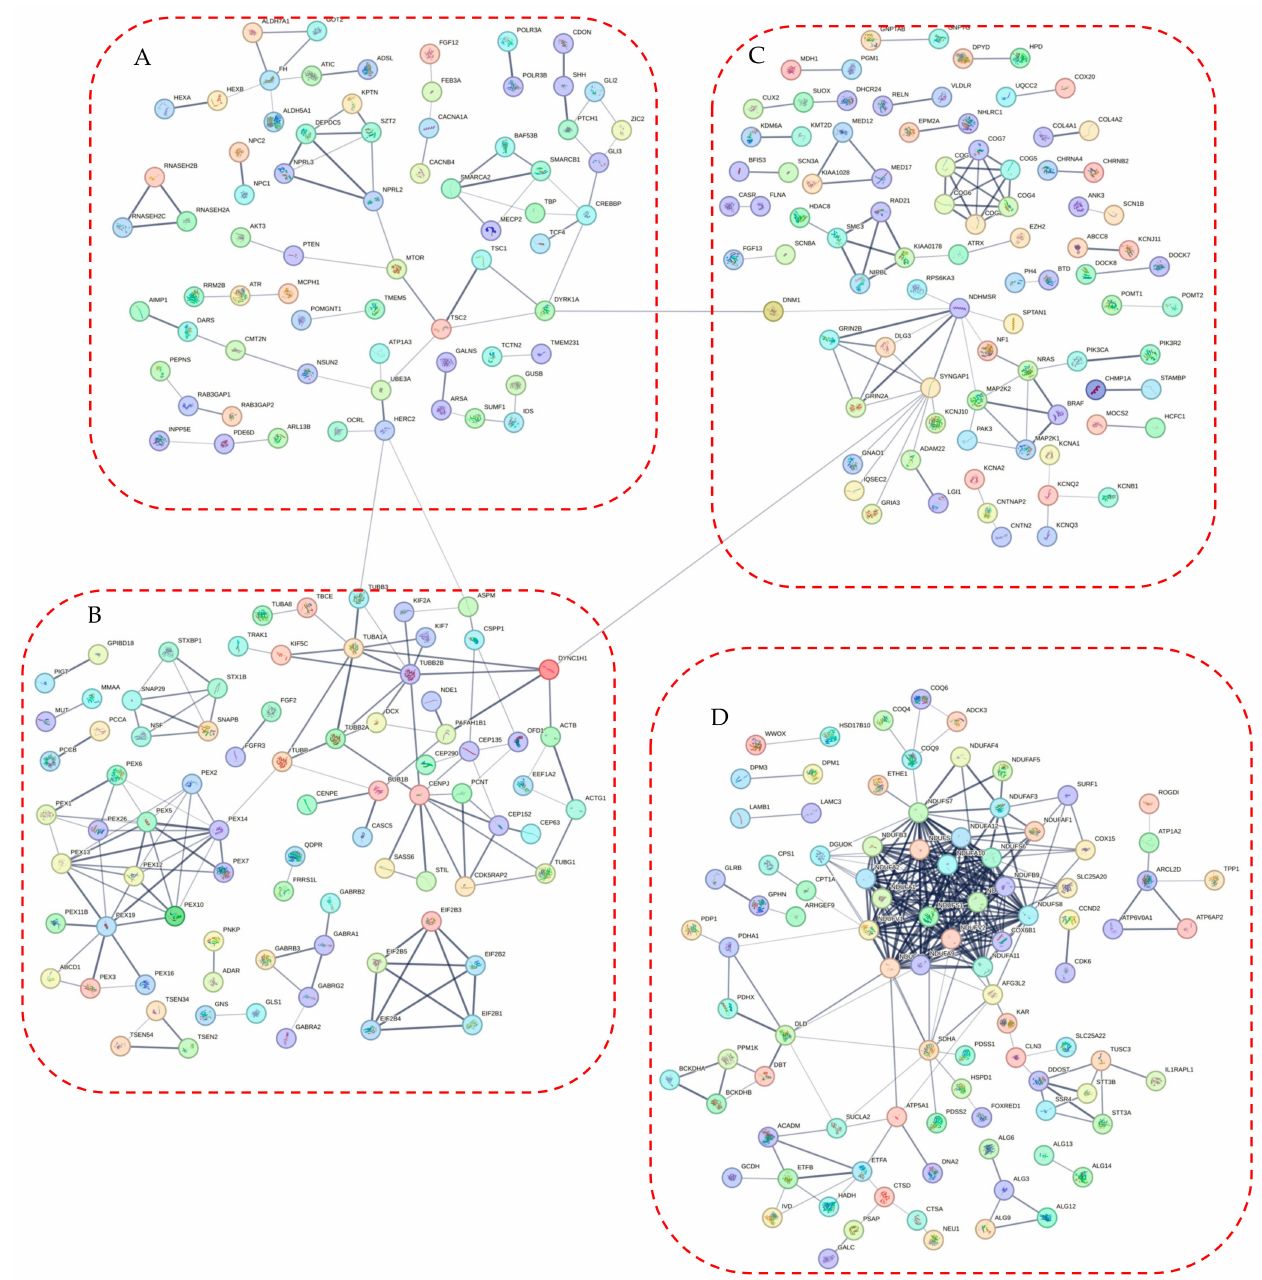
Figure 1. The protein-protein interaction (PPI) network obtained and visualized using the STRING database. Nodes denote individual proteins, thickness of edges represents their respective interaction scores. The network was divided into four panels ( A – D ); continued on the next pages, for conve- nience of visual presentation. Panel A mostly represents products of the mTOR system, chromatin remodeling, zinc fingers clusters and others intermediate genes. Panel B contains mainly cytoskeletal, cell division, peroxisomal, gamma-aminobutyric acid (GABA)-ergic and translation elongation initia- tion gene products. Panel C consists mainly of glutamate receptor- and potassium channel-related proteins. Panel D represents mitochondrial and N-oligosaccharyl transferase gene